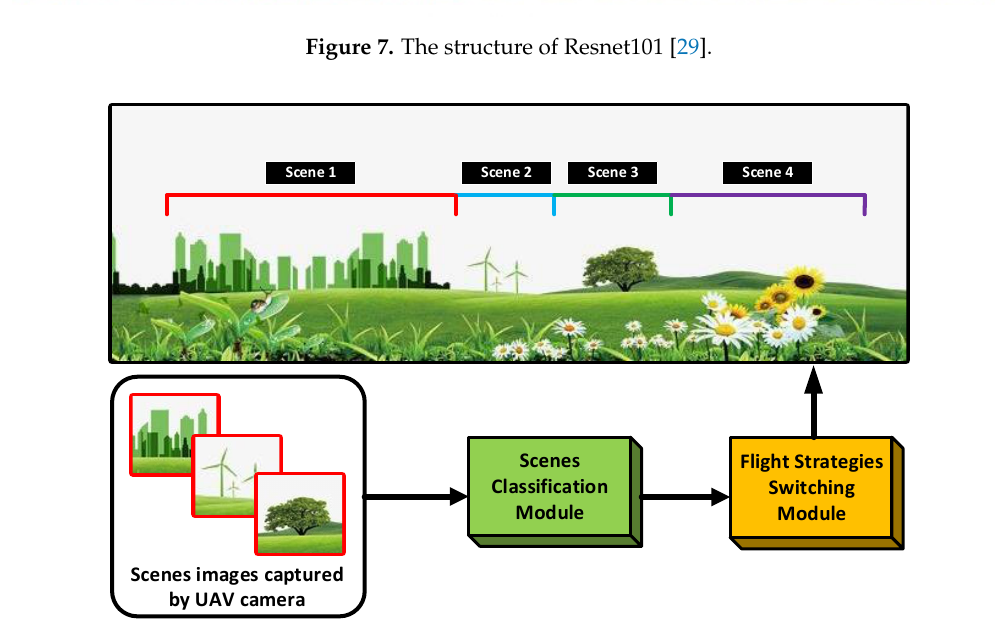
Figure 8. Diagram of scene understanding to automatically adjust the flight strategy under different working conditions. Table 1. UAV flight strategy corresponds to scene understanding result in our